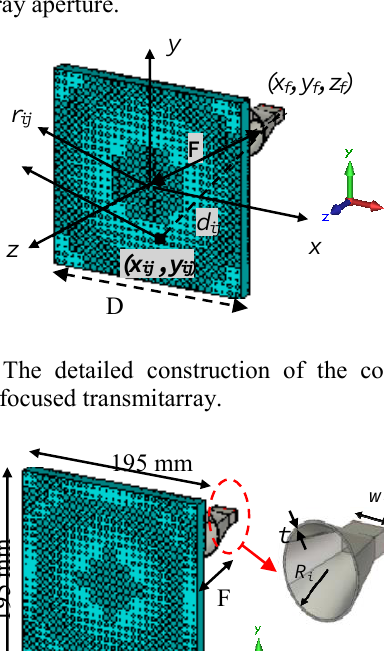
Figure 2: The NF focused at a distance z = R o from the transmitarray aperture.